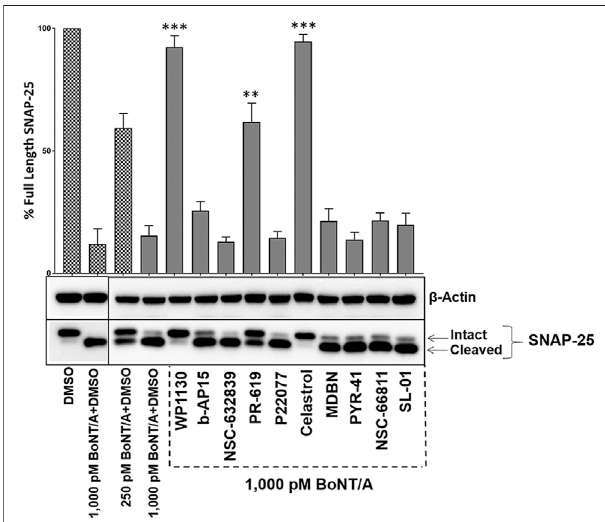
FIGURE7| WP1130,PR-619,andCelastrolareeffectiveagainstBoNT/ A post-intoxication. Mouse ES cell-derived motor neurons were exposed to BoNT/Aholotoxinatindicatedconcentrationsfor30 minandthentreatedwith 20 µMoftheselectedUPPmodulators.After4 hoftotalintoxication,cell lysates were prepared and subjected to western blotting to determine the degree of SNAP-25 cleavage. The blots were stripped and re-probed with β -Actinantibodiesastheloadingcontrol.Thevaluesaregivenasmean ± SEM from three independent experiments. Statistical signi fi cance was calculated for each compound treatment as compared to DMSO + toxin only (1,000pM BoNT/A) control condition run on the same blot, using GraphPad Prism (Student ’ s t -test). +++ , ++ Value signi fi cant at 99.9 and 99% con fi dence level,